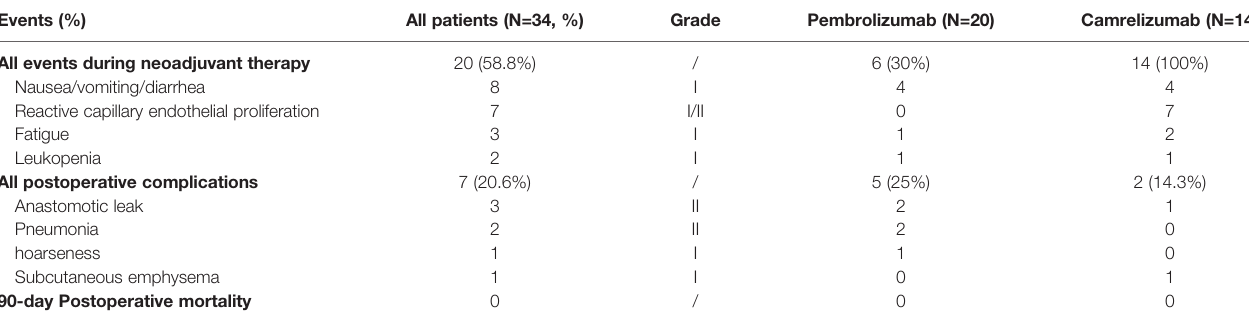
TABLE 2 | Adverse events during neoadjuvant immune checkpoint inhibitors plus chemotherapy and postoperative complications. Events (%)